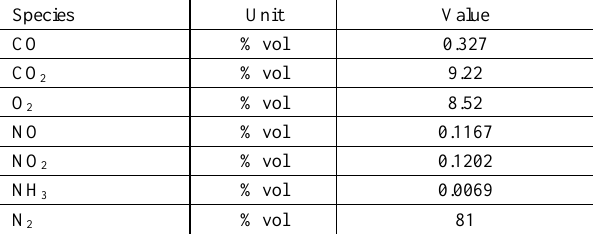
Fig. 6. Finite element mesh consisting of 344672 elements Table 3. Volumetric fractions of species in exhaust gases with added NH 3